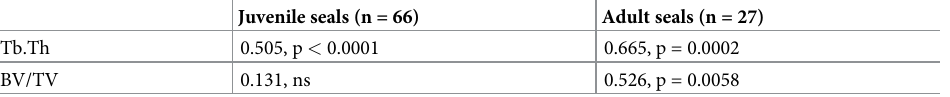
Table 3. Partial correlations, controlling for age, between cortical thickness and the variables Tb.Th and BV/TV in juvenile (age range: 0.5 to 23 months) and adult (age range: 12 to 25 years) harbor seals, Phoca vitulina ; ns = not significant.